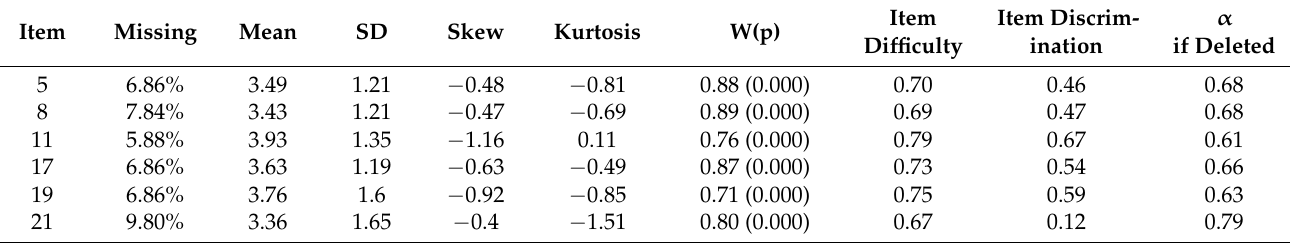
Table 4. Rasch analysis of the dimension 1 of the SCOOHPI.